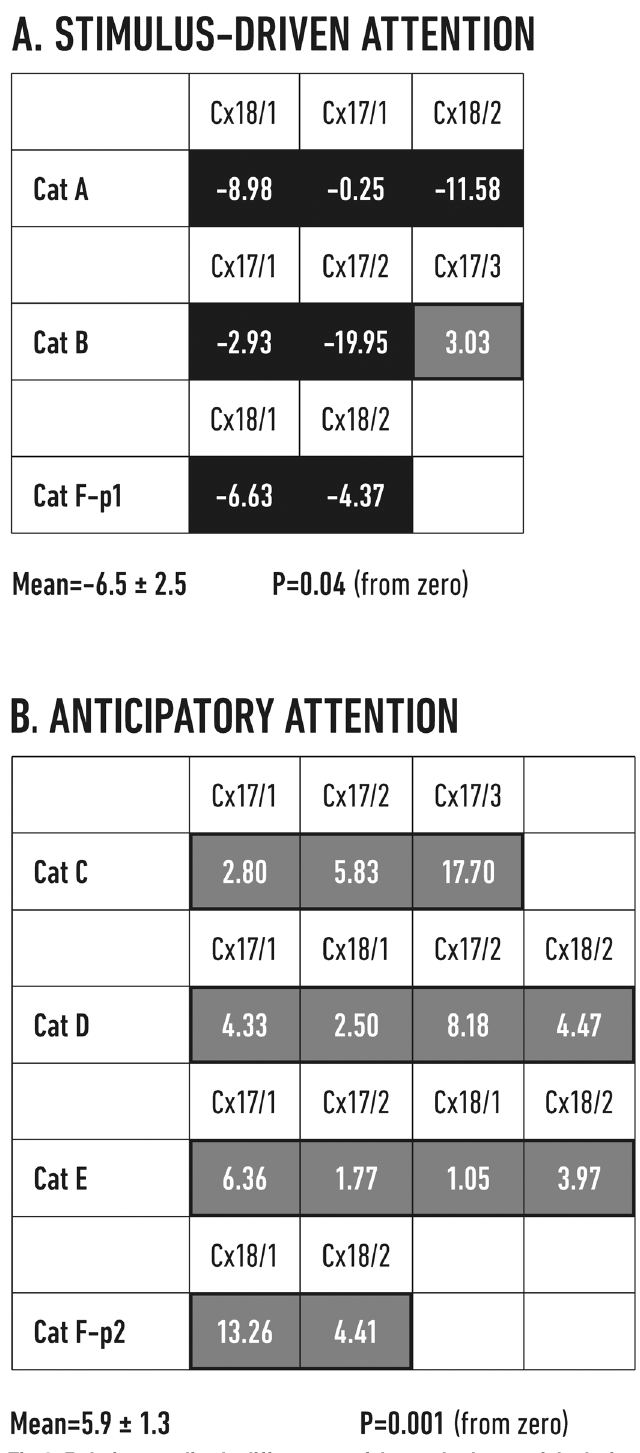
PLOS ONE | DOI:10.1371/journal.pone.0145379 January 5,